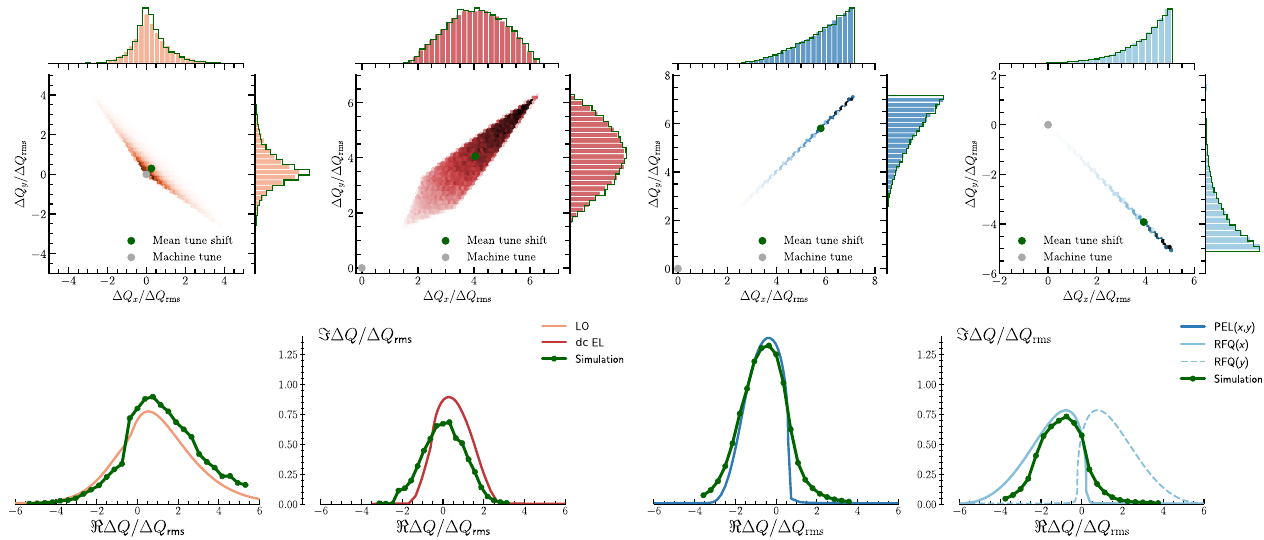
FIG. 4. Top: incoherent tune spreads and average tune shifts (green dot). Left to right: LO (yellow), a dc EL (red), a PEL (dark-blue), an RFQ (light-blue). Bottom: stability boundaries for the head-tail mode l ¼ 0 from Eq. (22) compared to the results of the simulation scans with the rigid mode kick, Eq.